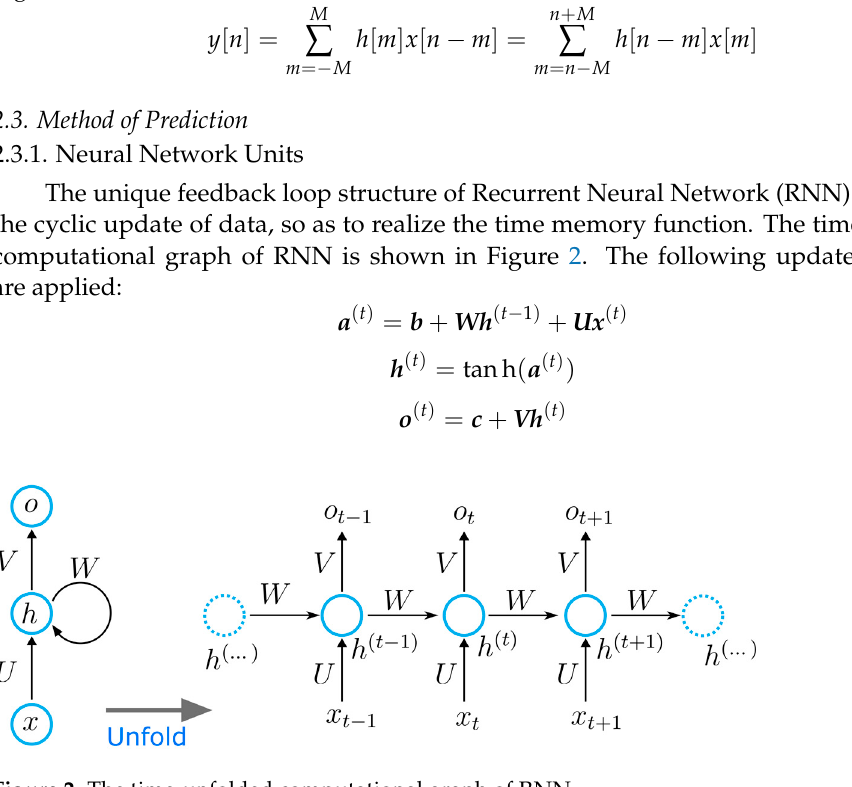
Figure 2. The time ‐ unfolded computational graph of RNN. Figure 2. The time-unfolded computational graph of